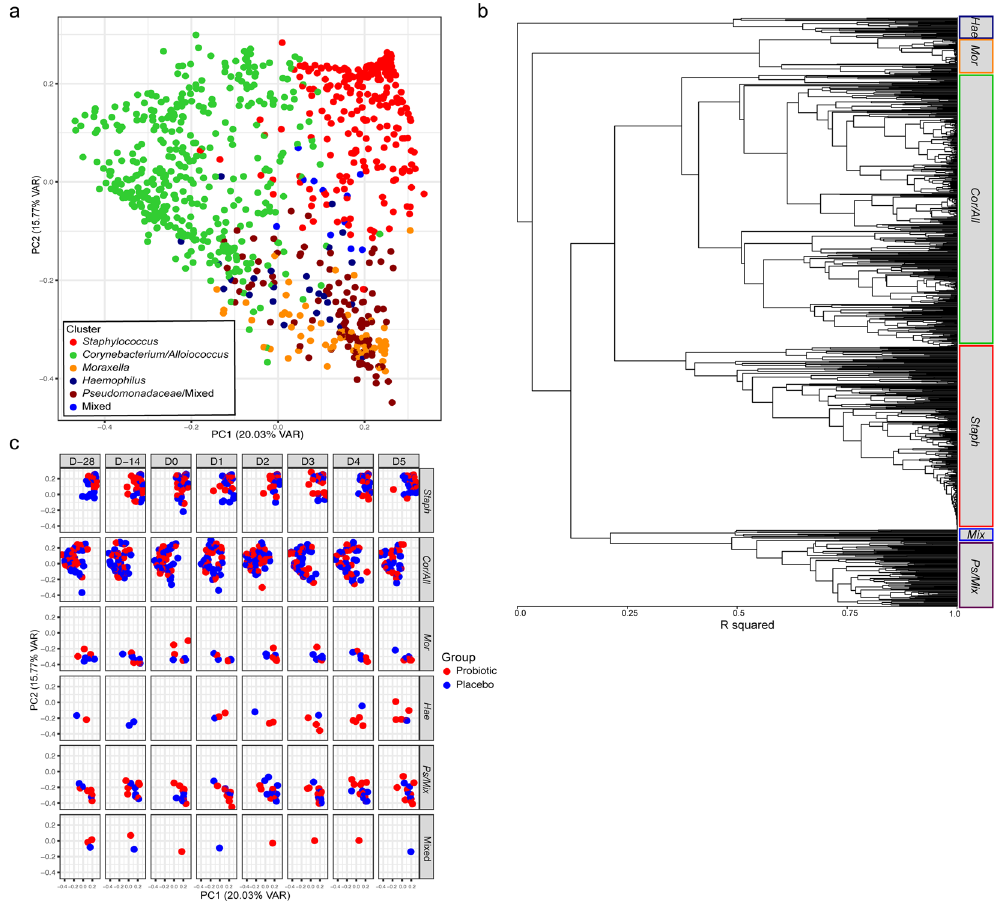
Figure 2. Clustering of nasal microbiota samples. ( a ) Principal coordinates plot showing clustering independent of time point and treatment. ( b ) Unweighted pair-group method (UPGMA) clustering of samples ( c ) Principal coordinates plot of sample distribution in different time points and treatment